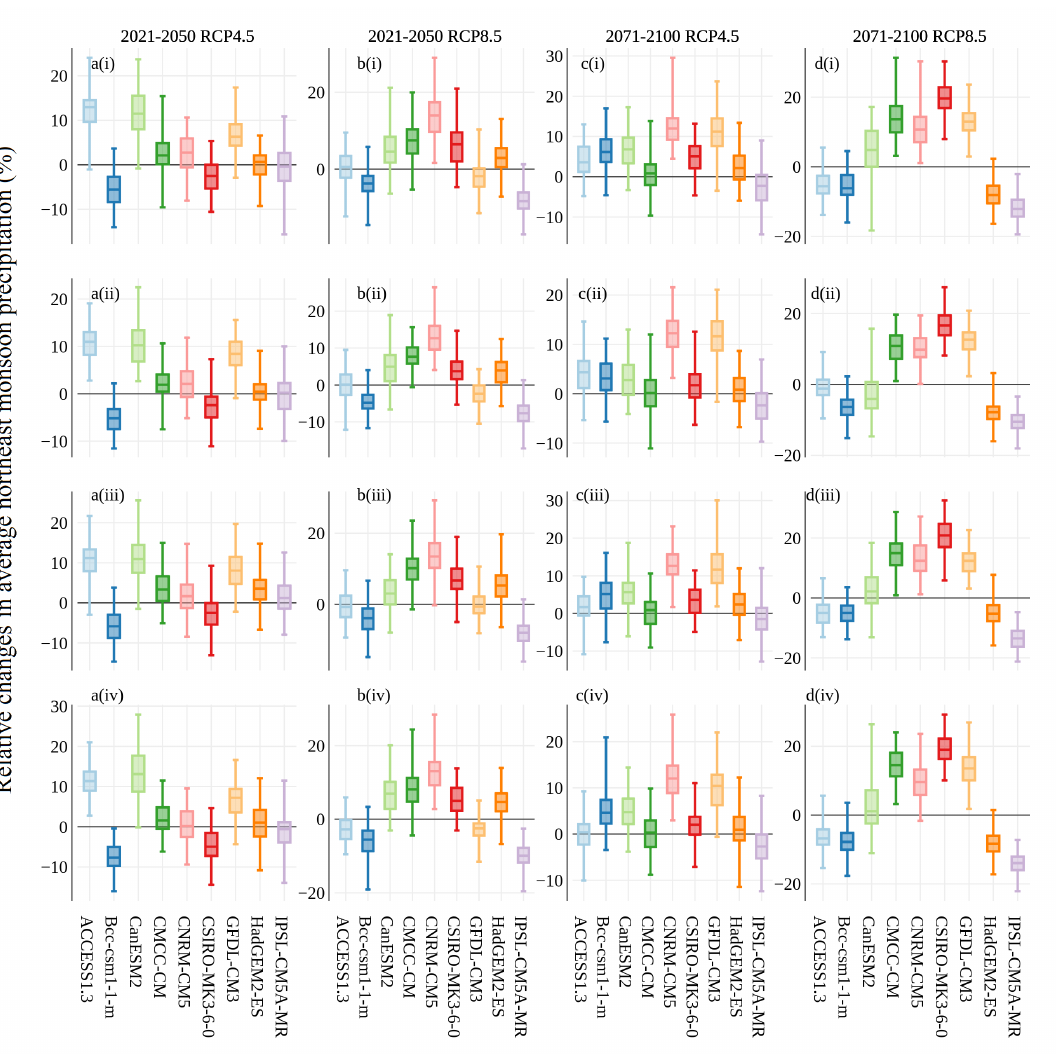
Figure 5. Relative changes (%) in long-term average northeast monsoon precipitation from downscaled GCM data for: ( a ) 2021–2050 period under RCP4.5 scenario; ( b ) 2021–2050 period under RCP8.5 scenario; ( c ) 2071–2100 period under RCP4.5 scenario; and ( d ) 2071–2100 period under RCP8.5 scenario relative to observed values during 1985–2014. Rows ( i – iv ) denote results for stations S06, S23, S24, and S25, respectively. The bottom, middle, and top of the box denote the first, second, and third quartiles, respectively. The lower and upper ends of the whiskers represent the minimum and maximum values,